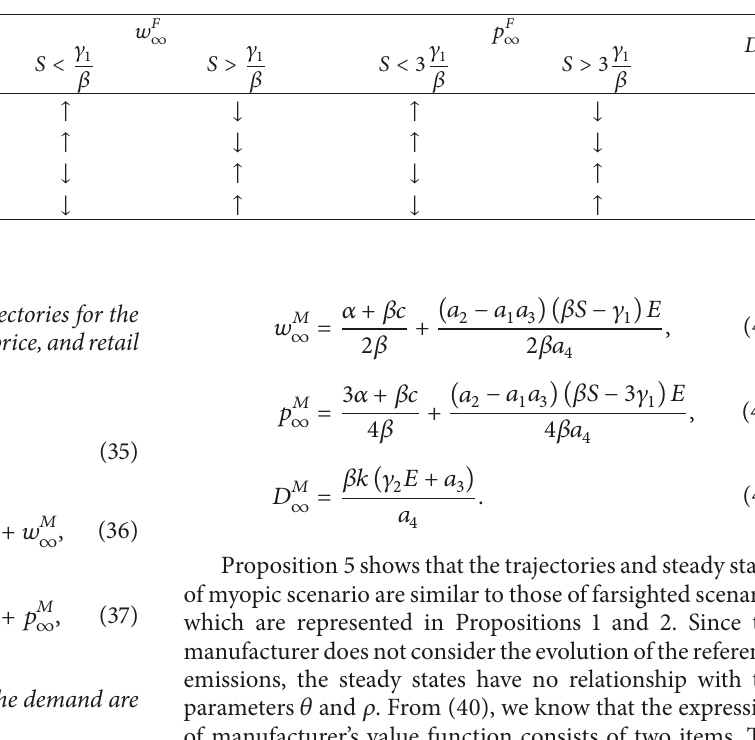
Table 1: Comparative static results for the farsighted